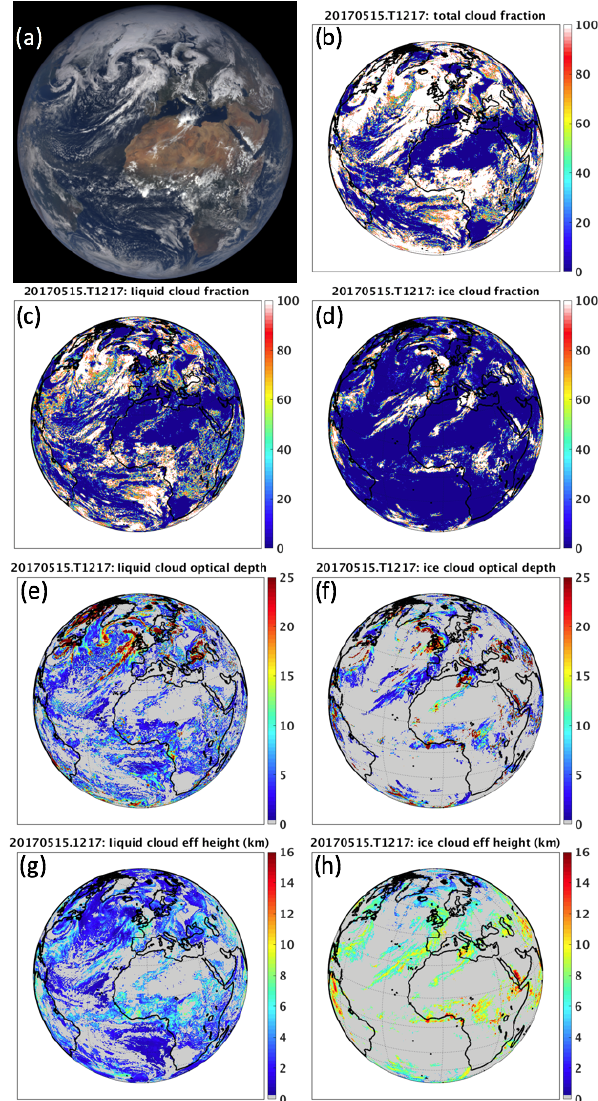
Figure 3. EPIC RGB image for 15 May 2017 at 12:17UTC (a) and the corresponding total cloud fraction ( b ; %). Liquid and ice cloud fractions are shown in (c) and (d) , liquid and ice cloud optical depths are shown in (e) and (f) , and liquid and ice cloud effective height (km) are shown in (g) and (h) . Panels (b) to (h) are all derived from the EPIC composite. Figure 3a is taken from: https://epic.gsfc.